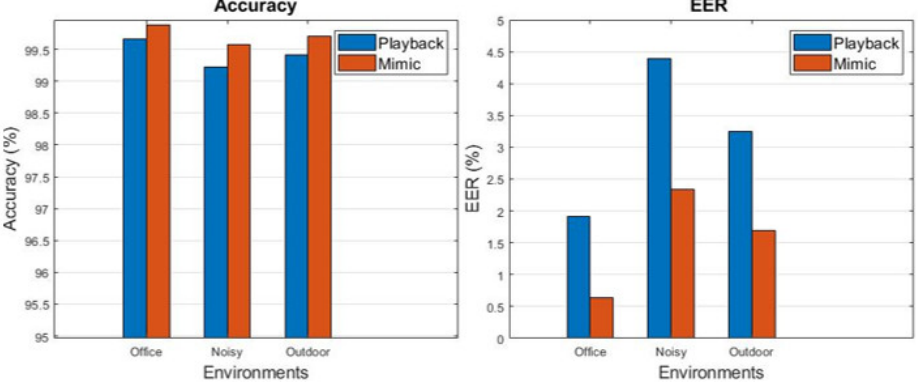
Figure 12. Accuracy and equal error rates for the three scenarios.